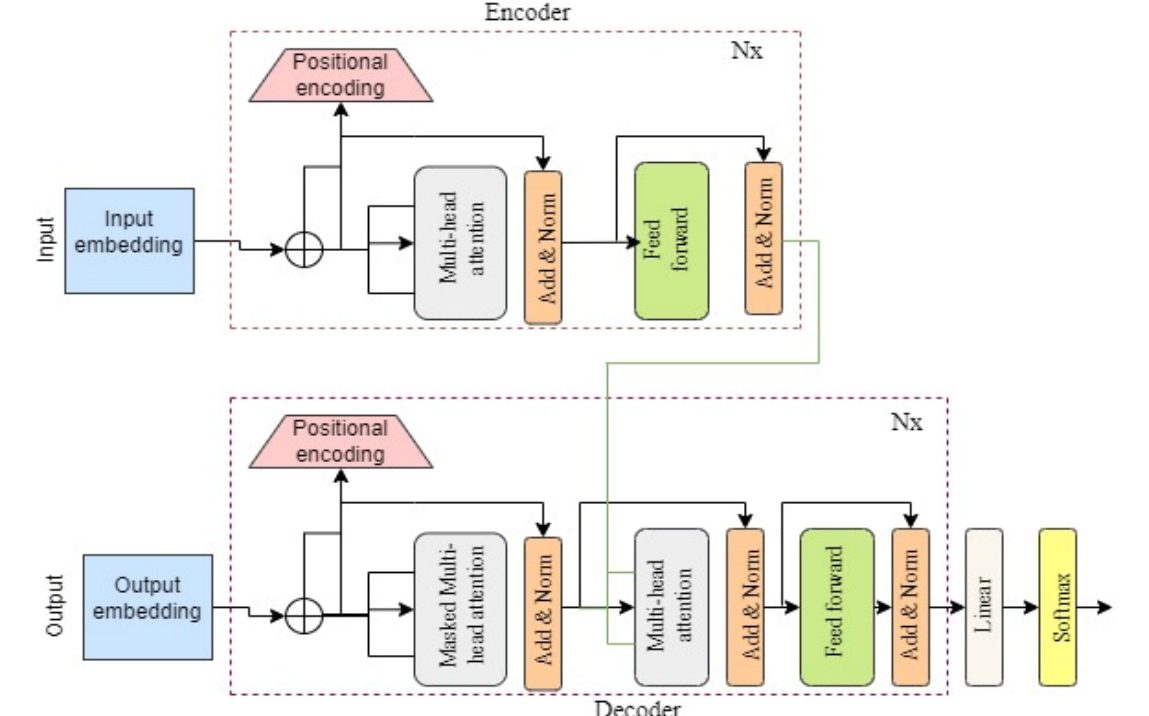
Figure 3. Transformer model (An input sequence is converted into a series of continuous represen- tations by the encoder component of the transformer’s architecture before being supplied to the decoder. The decoder combines the encoder’s output with the decoder’s output from the preceding time step to produce an output sequence).